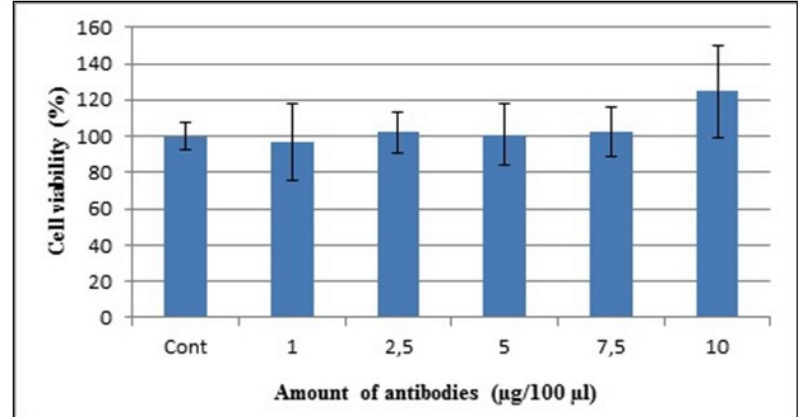
FIGURE 7 - MTT test for evaluation of anti-angiogenic properties of ranibizumab with prepared